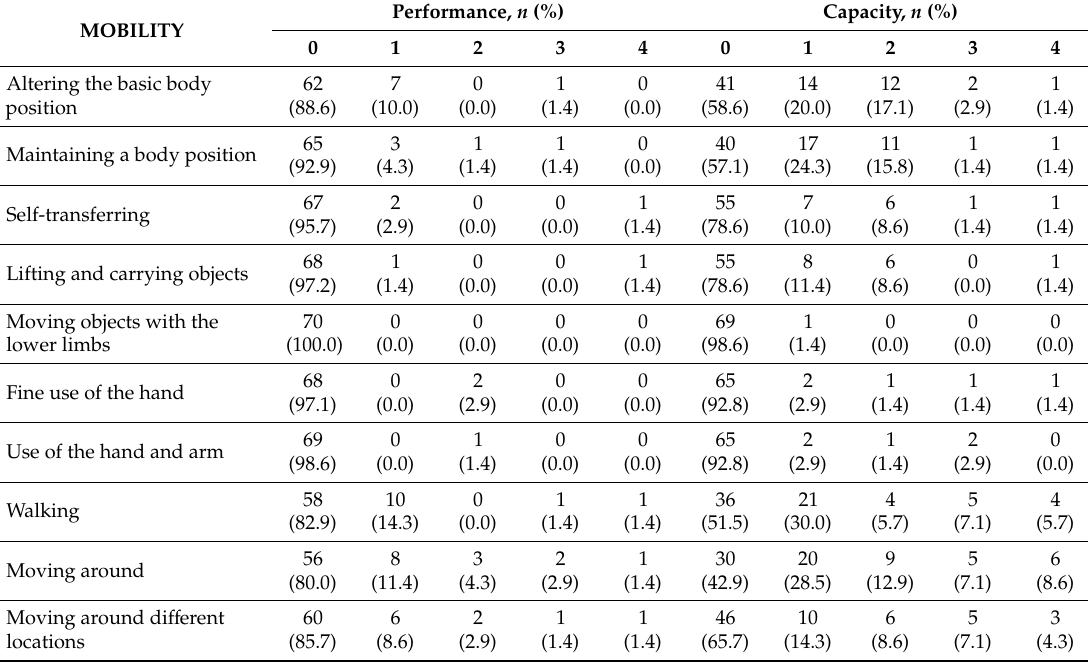
Table 2. Results of the “performance” and “capacity” qualifiers for the mobility and self-care domains of the International Classification of Functioning, Disability, and Health (ICF). Jo ã o Pessoa, PB, Brazil,